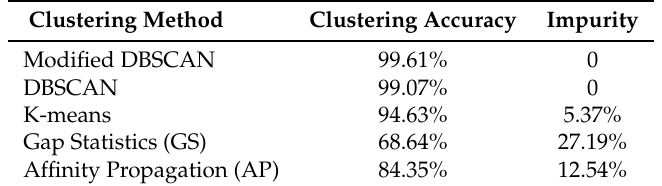
Table 2. Performance comparison of different clustering methods.